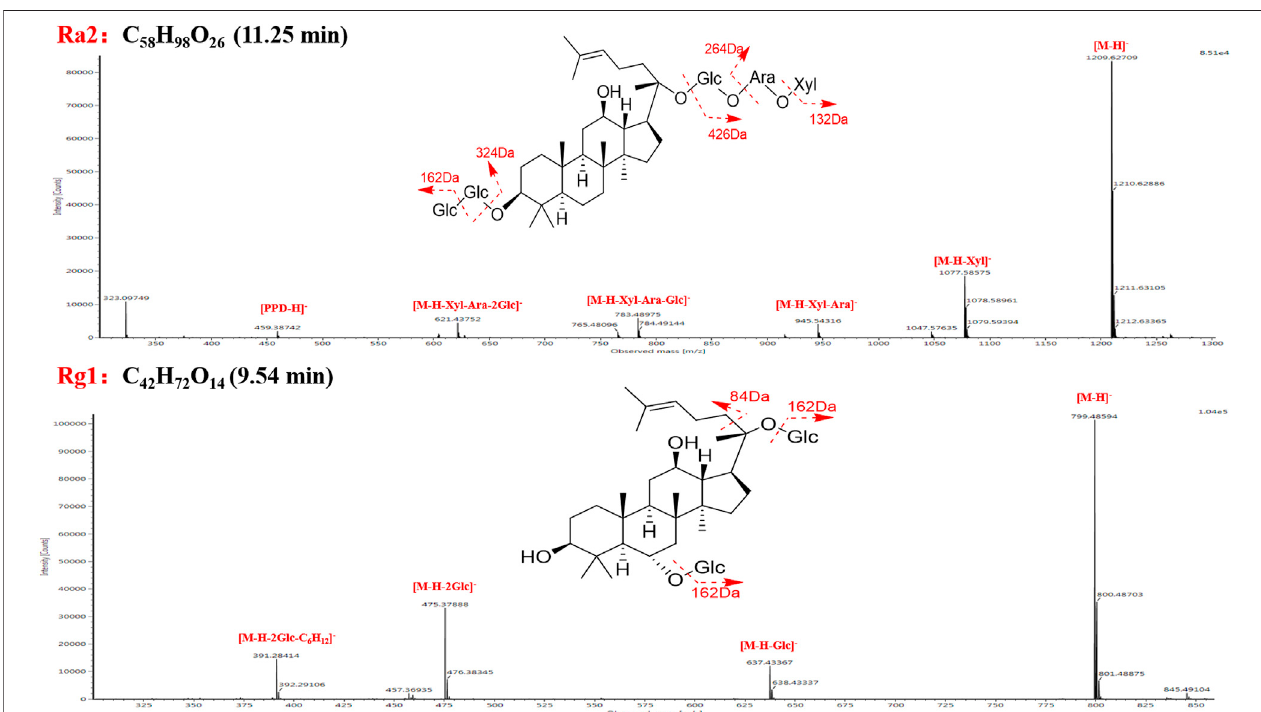
FIGURE 4 | Structural elucidation of ginsenoside Ra2 and Rg1 based on the negative CID-MS 2 data.